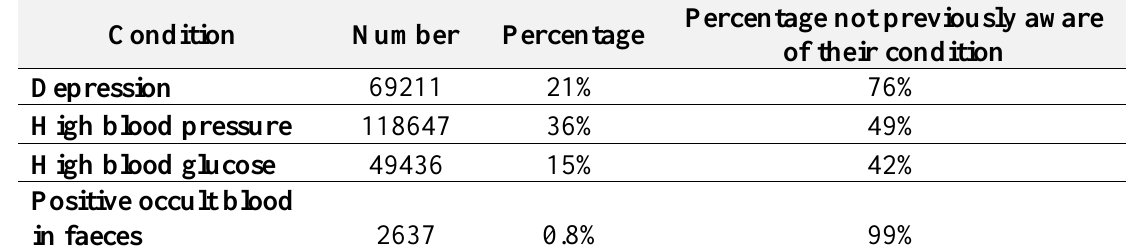
Table 2. Distribution of selected medical conditions among 329,576 individuals undergoing a medical check-up in Albania in 2016